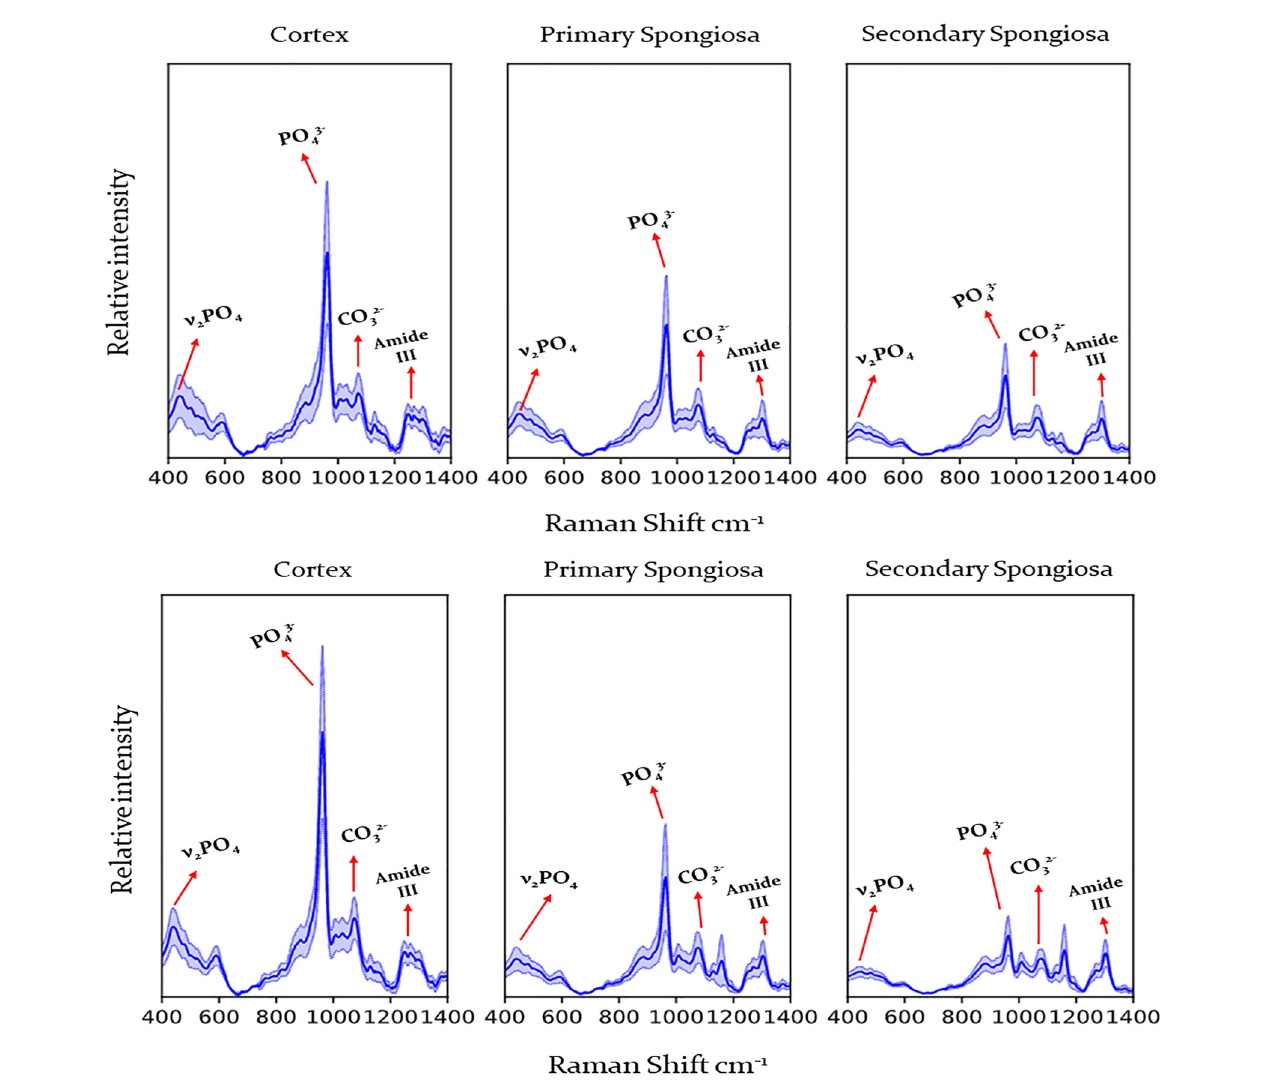
FIGURE2 Raman spectra obtained from the humerus from cows with humeral fracture (upper graph) and control cows (no fractures) (lower graph) by location (cortex, primary, and secondary spongiosa). Labels indicate peaks used for calculation of mineral/matrix ratio, carbonate/phosphate ratio and crystallinity. Dark line indicates mean, pale blue line 95% confidence interval. PO 3 − 4 , phosphate; CO 2 3 ,